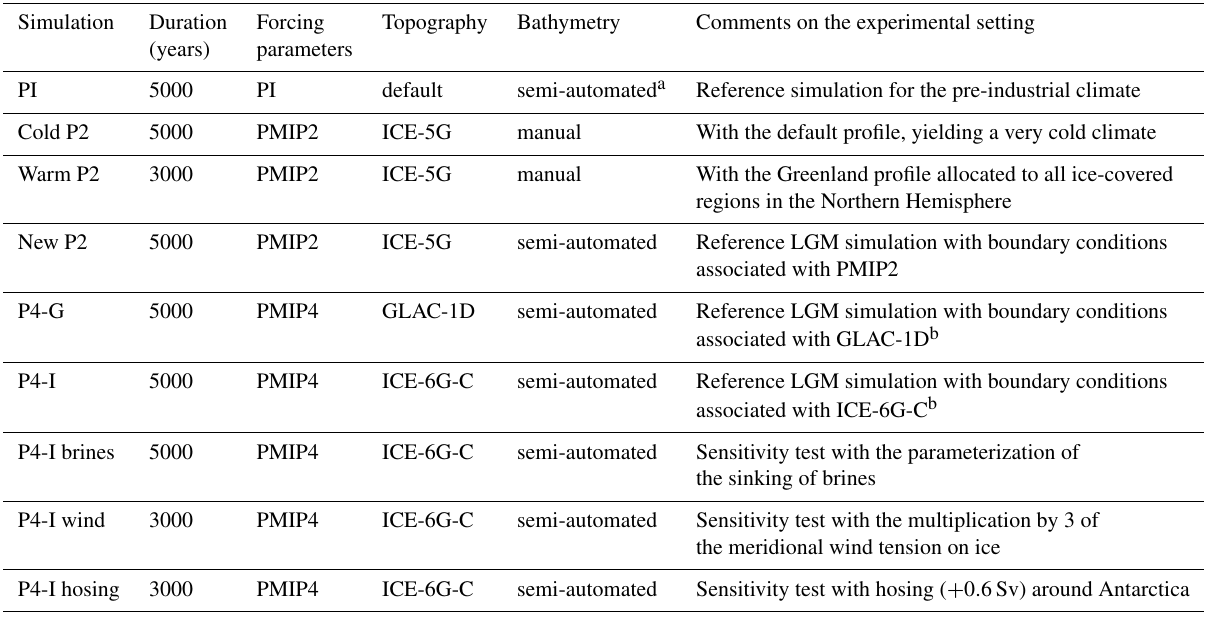
Table 1. Short description of the iLOVECLIM simulations. Simulation Duration Forcing Topography Bathymetry Comments on the experimental setting (years) parameters PI 5000 PI default semi-automated a Reference simulation for the pre-industrial climate Cold P2 5000 PMIP2 ICE-5G manual With the default profile, yielding a very cold climate Warm P2 3000 PMIP2 ICE-5G manual With the Greenland profile allocated to all ice-covered regions in the Northern Hemisphere PMIP2 ICE-5G semi-automated Reference LGM simulation with boundary conditions associated with PMIP2 GLAC-1D semi-automated Reference LGM simulation with boundary conditions associated with GLAC-1D b semi-automated Reference LGM simulation with boundary conditions associated with ICE-6G-C b semi-automated Sensitivity test with the parameterization of the sinking of brines Sensitivity test with the multiplication by 3 of the meridional wind tension on